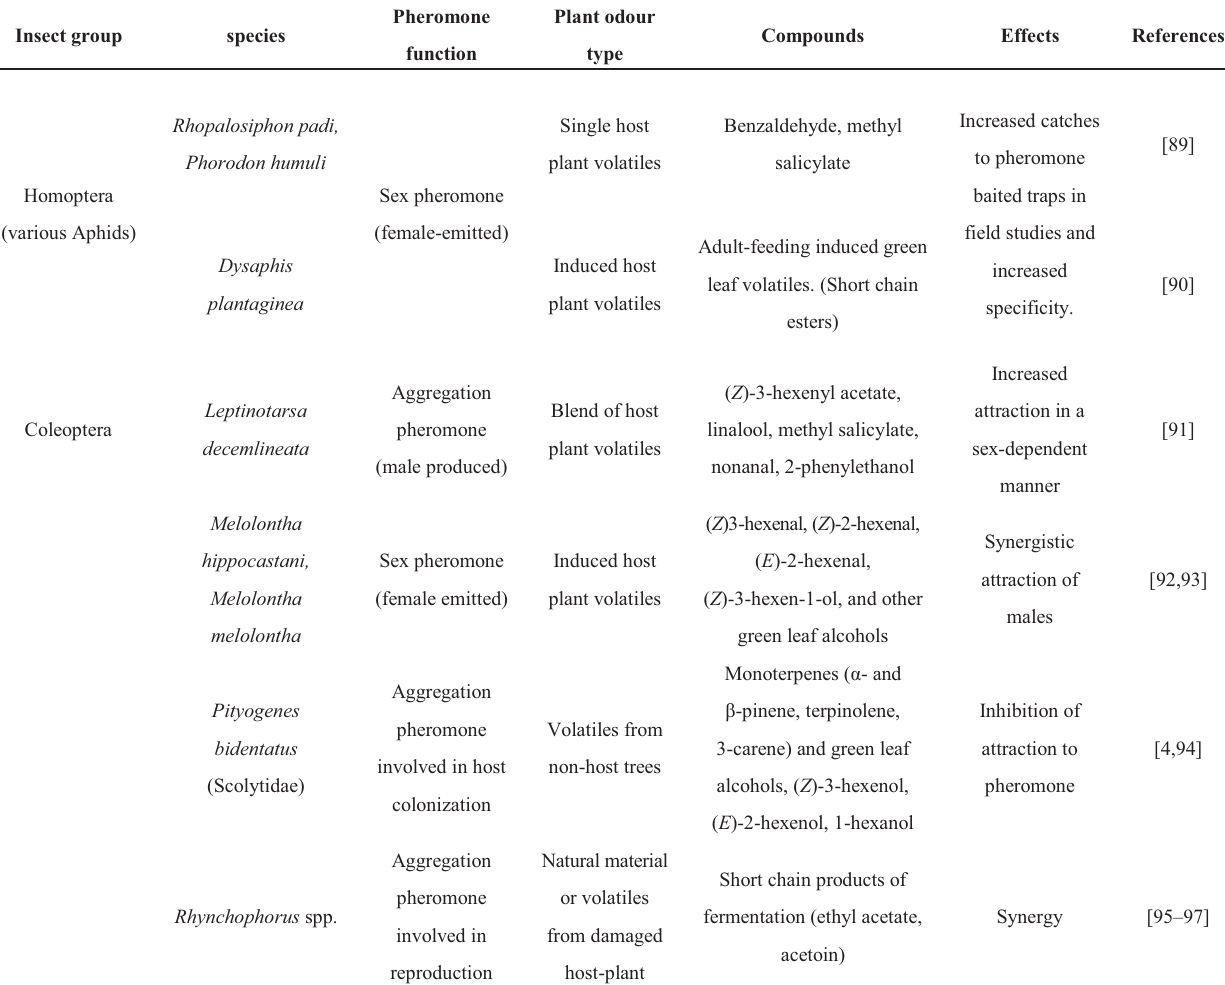
Table 1. Some reported cases of pheromone-plant odor interactions in non-lepidopteran insects. Insect